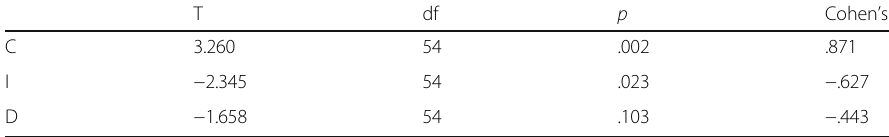
Table 5 Independent samples T-Test for equality of means T df p Cohen ’ s d 3.260 54 .002